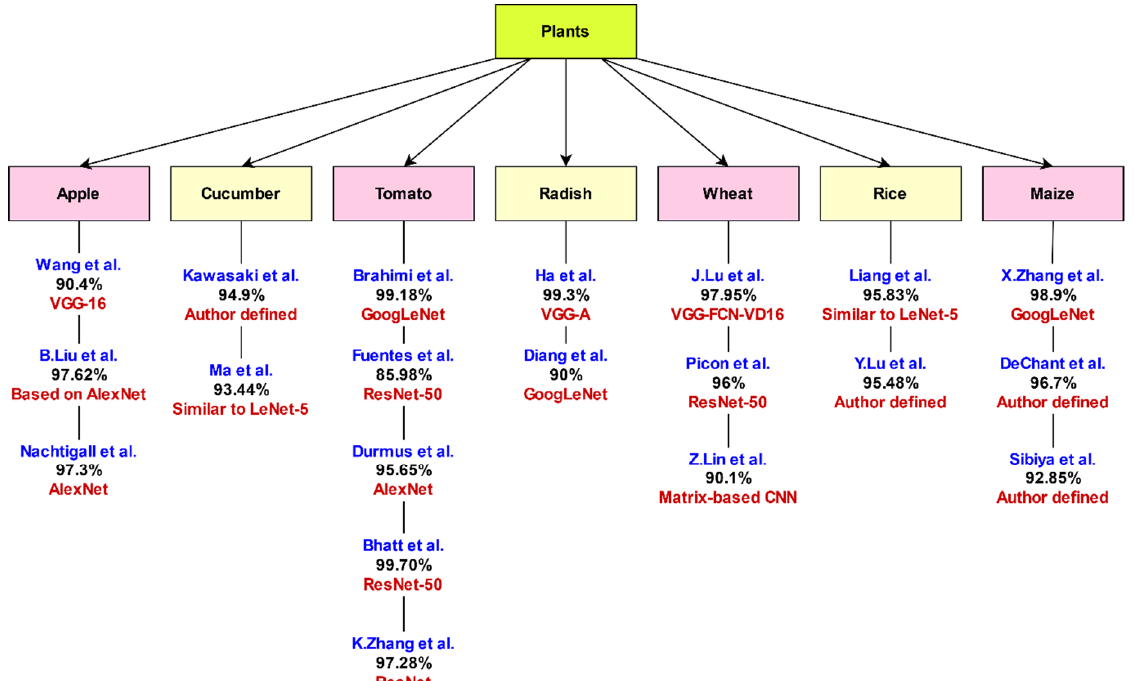
Figure 11. Comparison of CNN architectures based on plant types and accuracy.